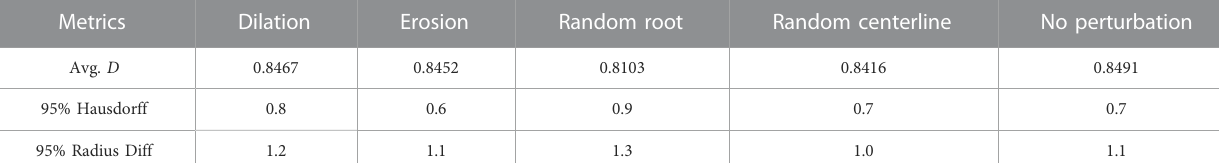
TABLE 6 Performance of the proposed model with different perturbation schemes applied to the initial segmentation and the centerline.